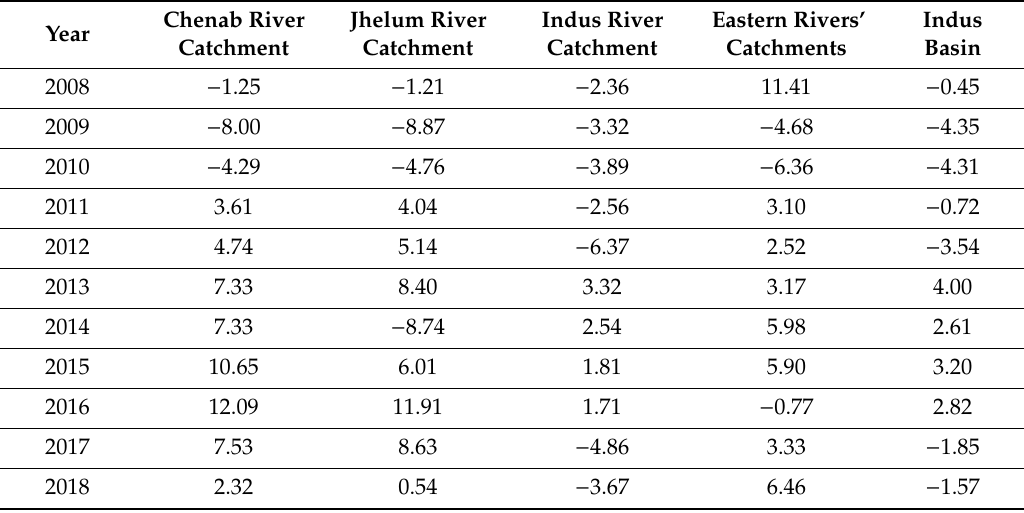
Table 4. Annual percent di ff erence in maximum snow cover area of MOD09GA with respect to